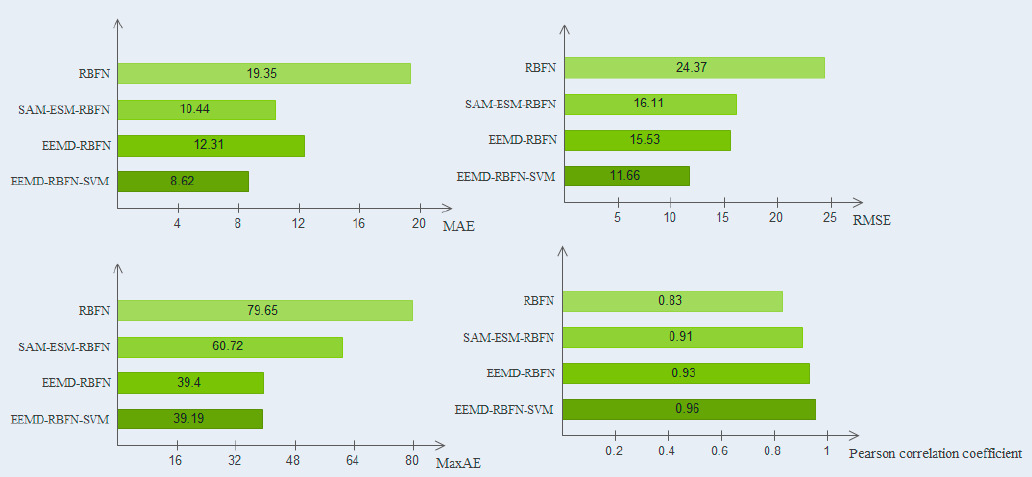
Figure 10. Evaluation index bar chart. Table 1. Forecasting results by different models.